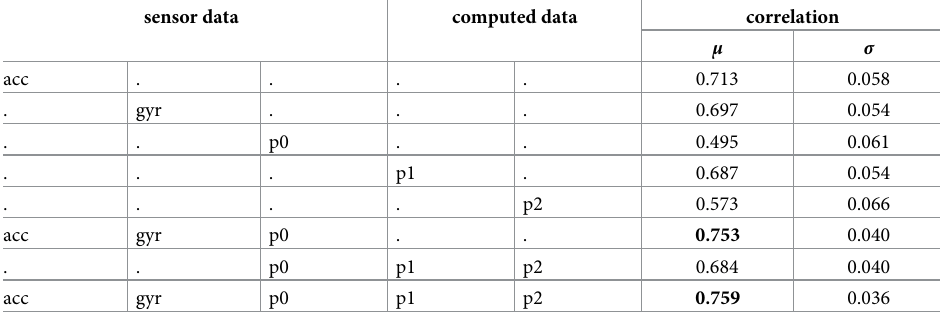
Table 1. Pearson correlation coefficient mean and standard deviation across cross-validation splits for different input feature combinations. The two highest coefficients are marked in bold (statistically not different).